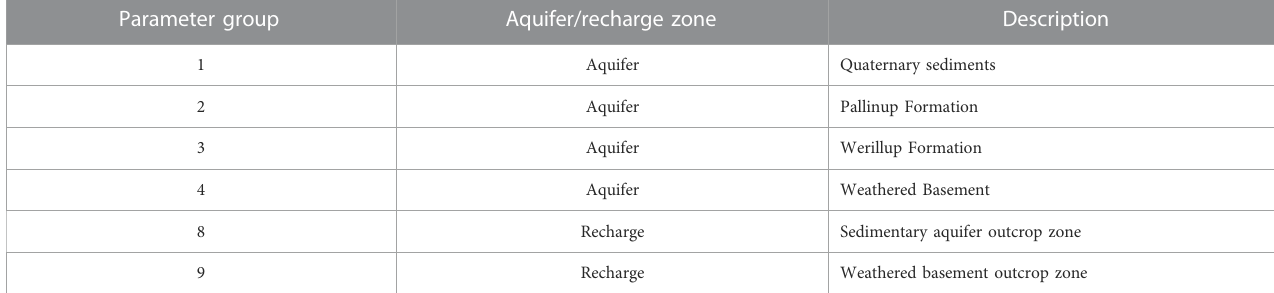
TABLE 2 Parameter group descriptors used in parameter name de fi